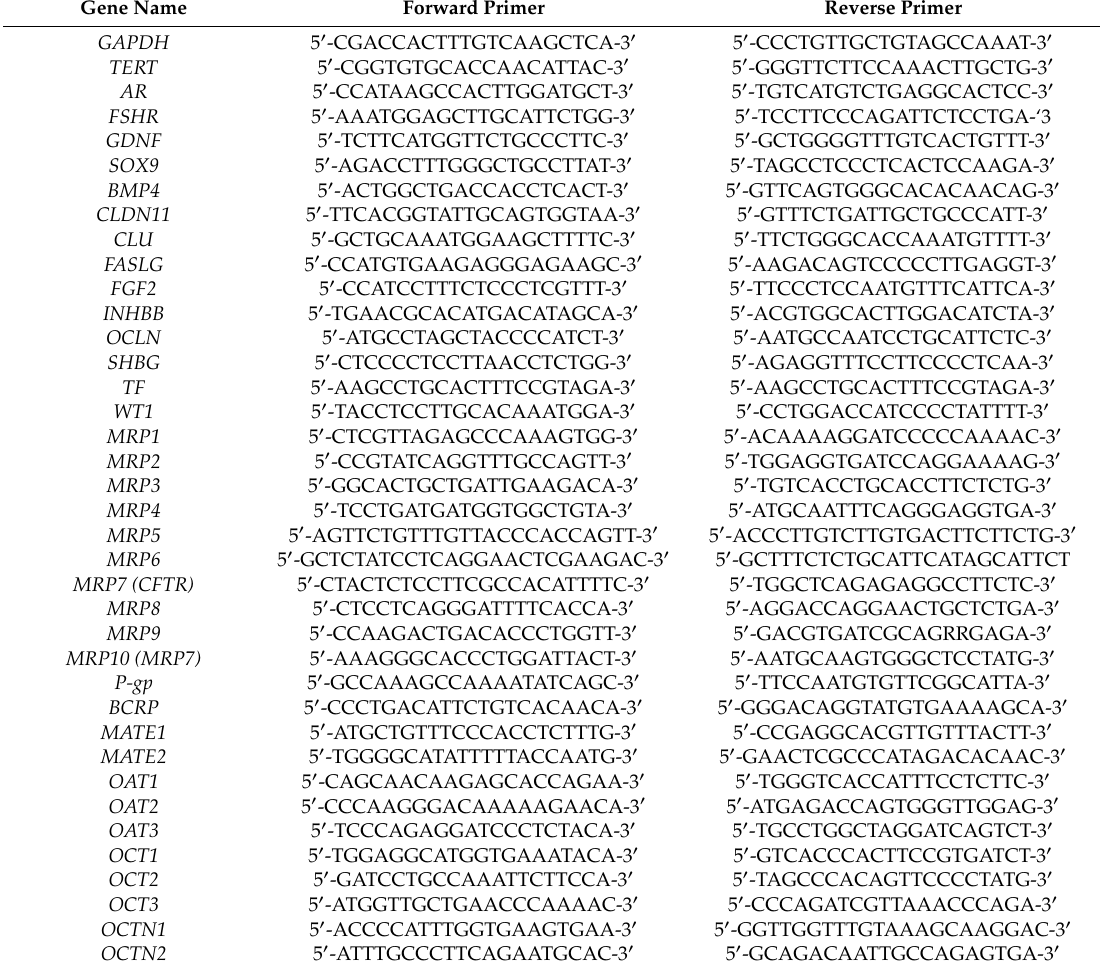
Table 1. List of forward and reverse RT-qPCR primers used in this